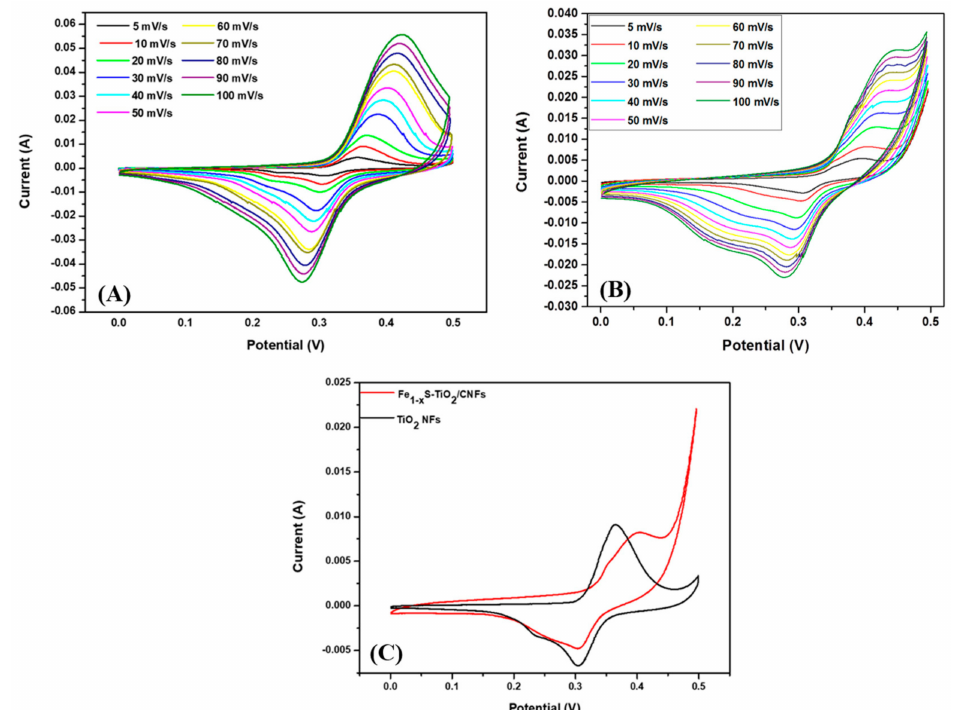
Figure 6. Cyclic voltammetry (CV) curves of TiO 2 NFs ( A ) and Fe 1 − x S-TiO 2 / CNFs composite electrode ( B ) at various scan rates. ( C ) shows the CV results for the TiO 2 NFs and Fe 1 − x S-TiO 2 / CNFs composite electrodes at a 10 mV / s scan rate.